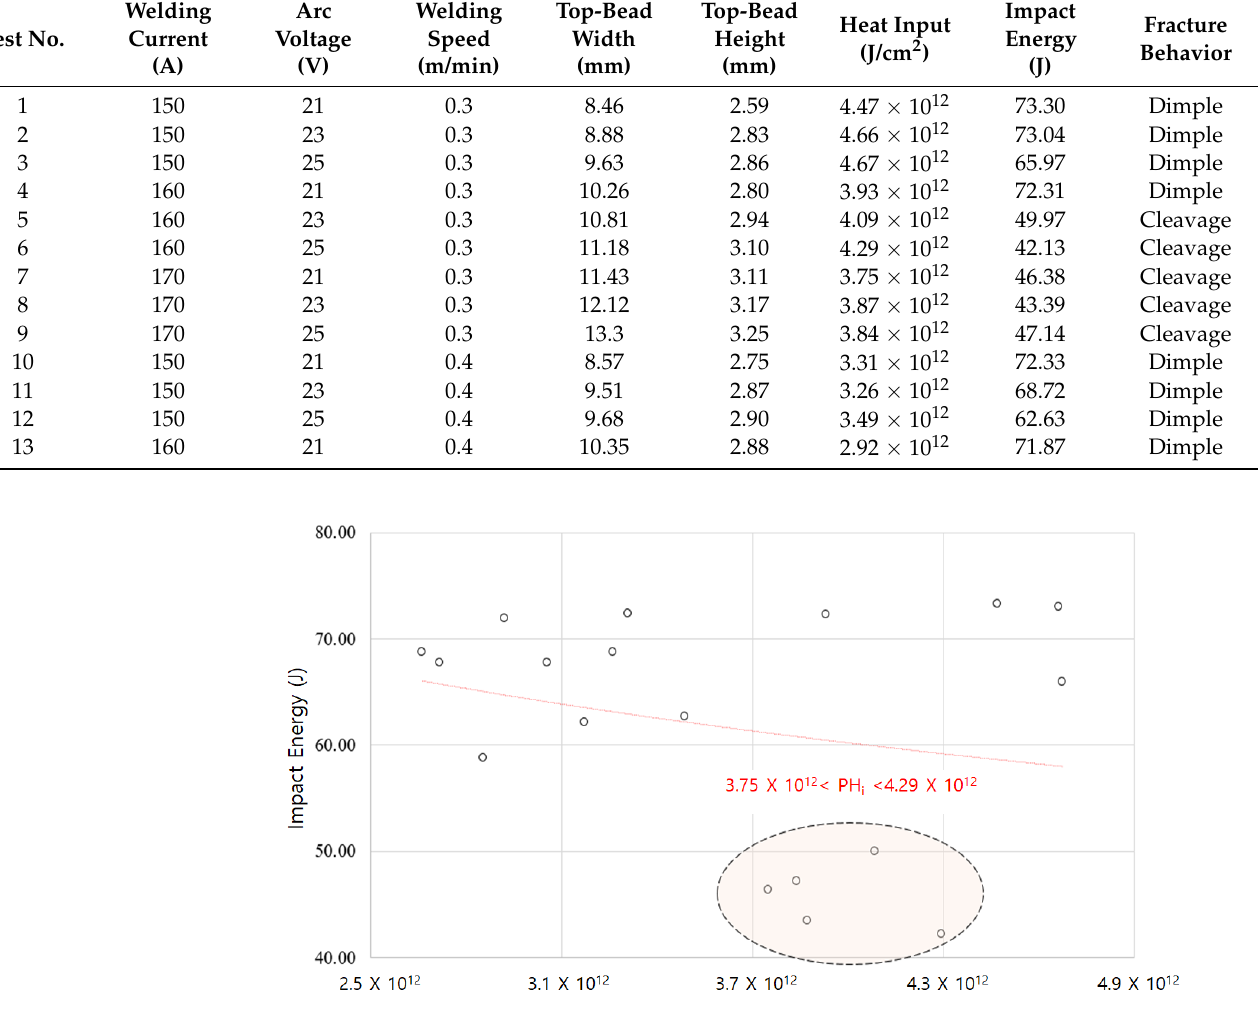
Table 8. Results of fracture behavior according to heat input in flux core arc welding.